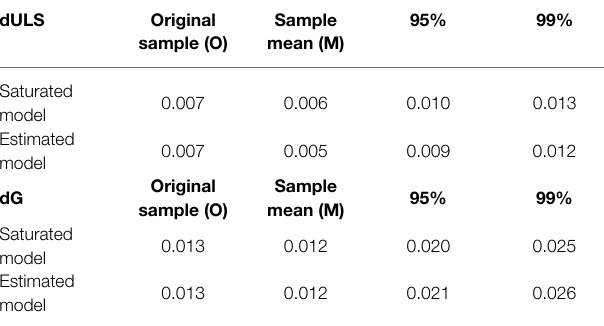
TABLE 7 | Measure of fit according to the dULS and the